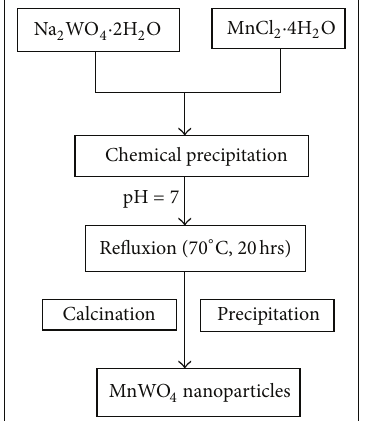
Figure 1: The scheme of preparation of MnWO 4 nanoparticles by chemical precipitation method.